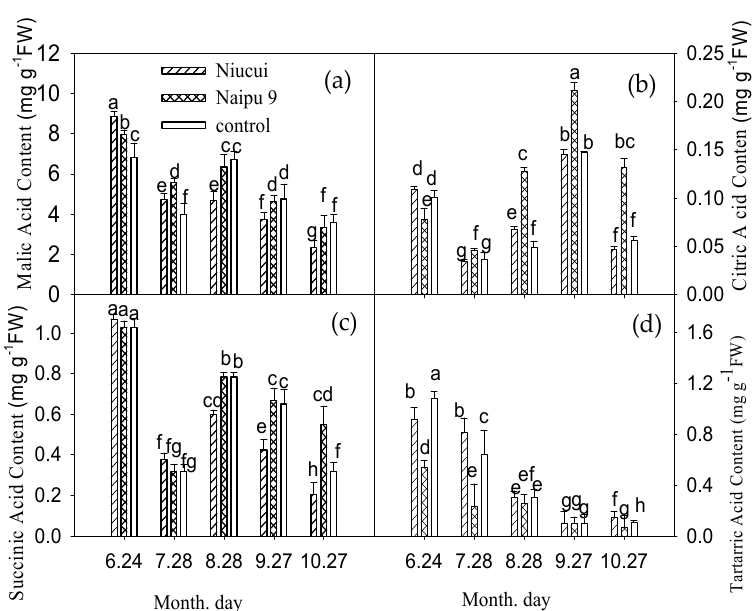
Figure 3. Effects of spraying calcium fertilizer on ( a ) malic acid, ( b ) citric acid, ( c ) succinic acid, and ( d ) tartaric acid contents in apple fruit. The values represent mean ± S.E. of three replicates. Bars indicate S.E. Bars with the same letter were not significantly different at p < 0.05.